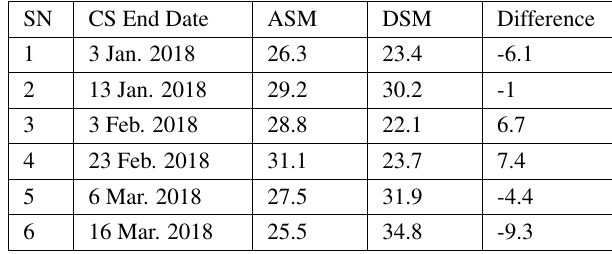
Table 2. Performance of the regression models in Scenario 1 Model